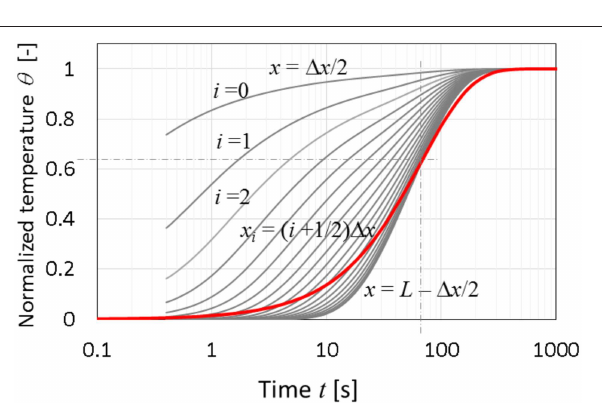
FIGURE 2 | Thermal network diagram of a lumped mass thermal model. Depending on contacting to the hot or cold, the energy flow direction is changed by the switch (SW).